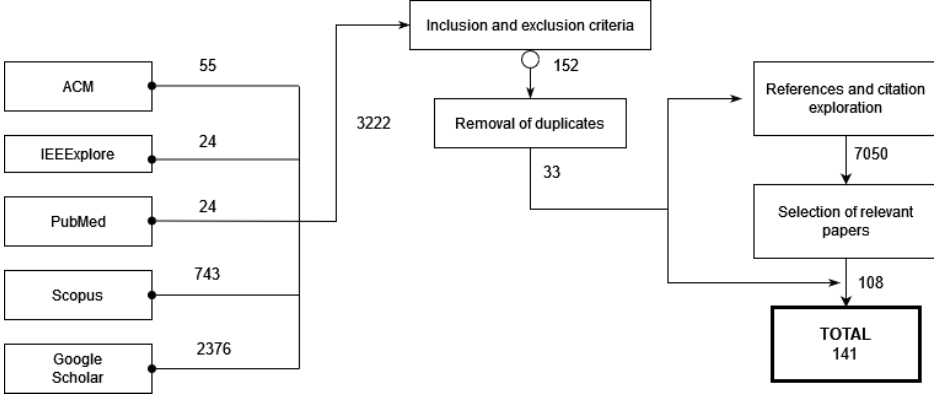
Figure 1. Research